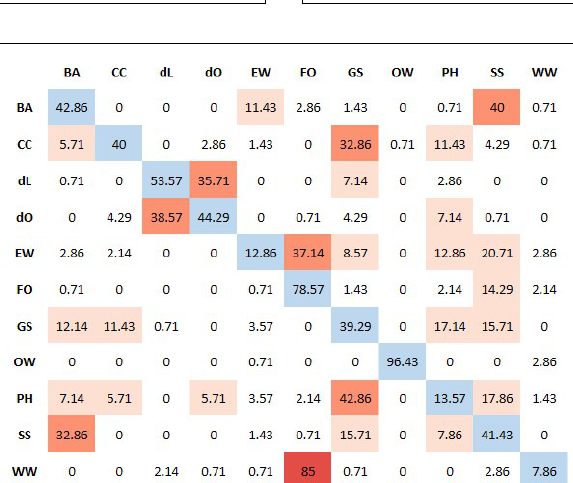
Figure 3: Comparison of patterns of responses of five experiments. Row/column names of each matrix represent unique land cover classes the participants could choose from (Barren, Cultivated Crops, Developed Low Intensity, Developed High Intensity, Emergent Herbaceous Wetlands, Forest, Grassland, Open Water, Pasture/Hay, Shrub/Scrub, Woody Wetlands). The first three matrices (left to right) represent the first three experiments, testing the influence of expertise in classification. The last two represent the last two experiments, testing the influence of added aerial photos. Results show agreement against NLCD data, more precisely the numbers represent how often images of the class given by the row have been categorized as the class given by the column (i.e., a confusion matrix). Darker (red) colors indicate higher error rates. More important is the comparison of similarity between